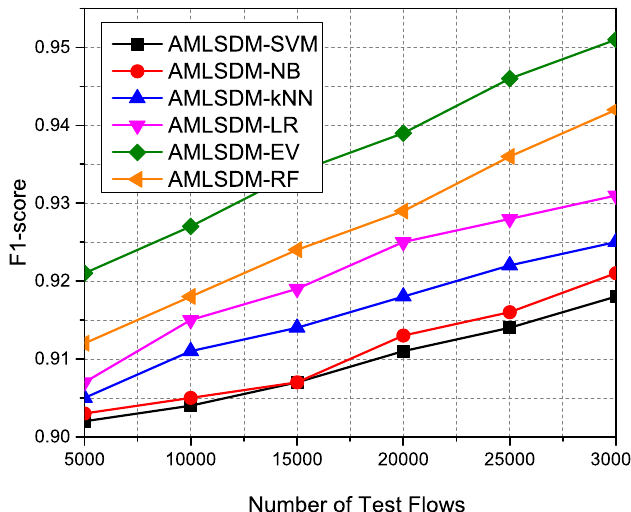
Figure 24. Precision performance of ML classifiers.